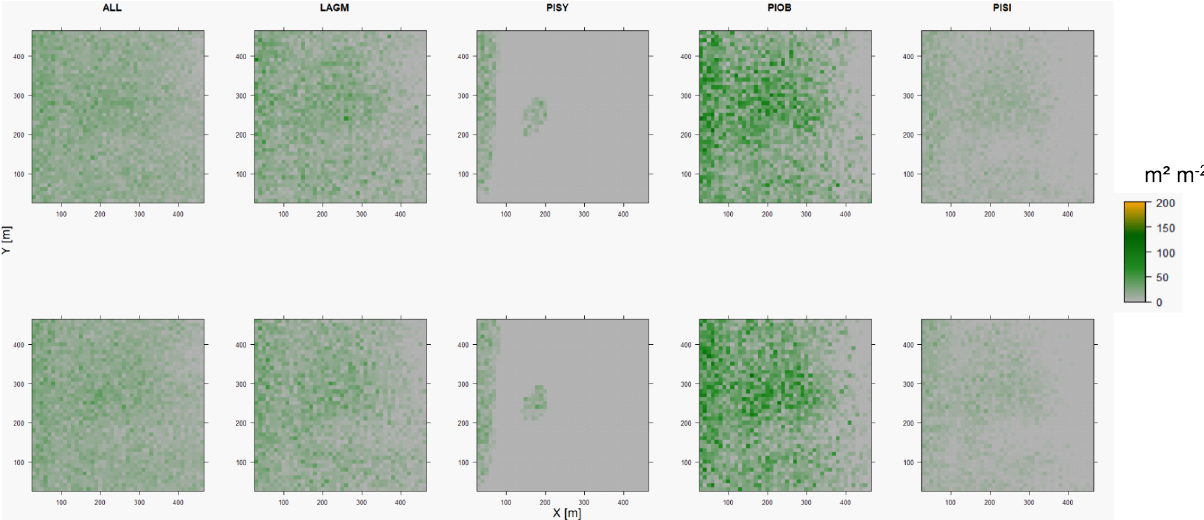
Figure D1. Leaf area index (LAI) values of the CryoGrid grid aggregated at year 2015 at Lake Khamra. Upper row shows LAVESI–CryoGrid coupled; lower row shows LAVESI simulations. LAGM: Larix gmelinii ; PIOB: Picea obovata ; PISI: Pinus sibirica ; PISY: Pinus sylvestris .